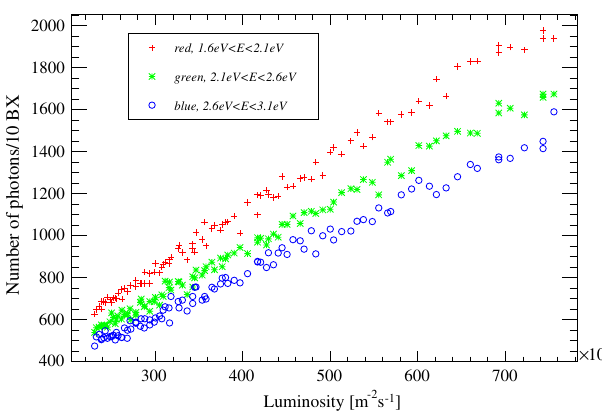
FIG. 22. Correlation between luminosity and number of tertiary photons (per 10 bunch crossings) when the size of one beam is varied. Each color in the optical region corresponds to an energy bin of 0.5 eV